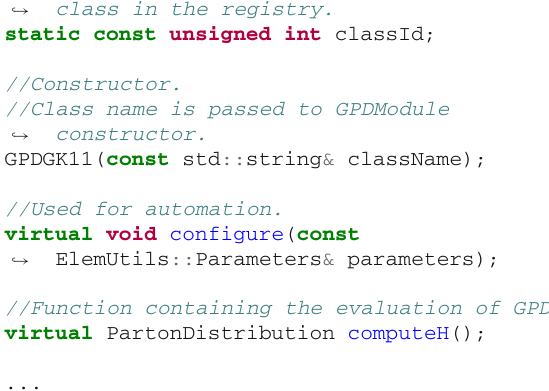
Table 1 The variables used in evaluating GPDs